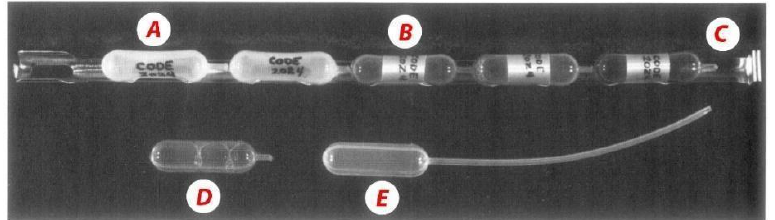
Figure 5. Plastic (polyethylene) Pasteur pipette used for freezing. Taken from the Walter Reed Army Institute of Research; by Jackson et al., 1981 [82].